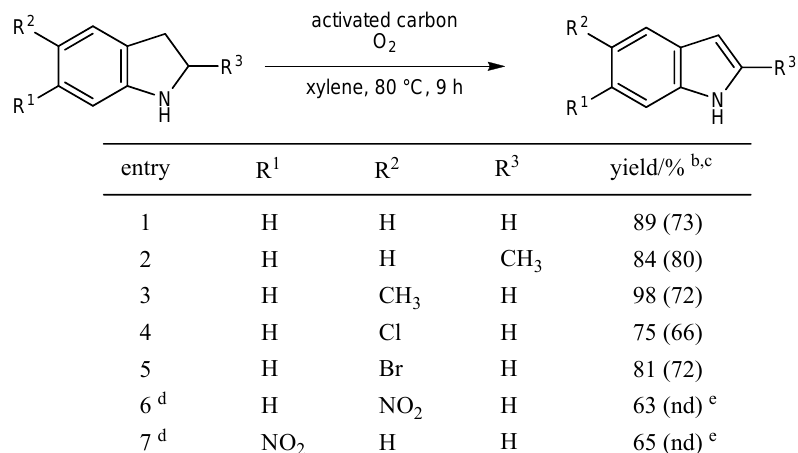
Table 4. Oxidative conversion of substituted indolines into indoles.